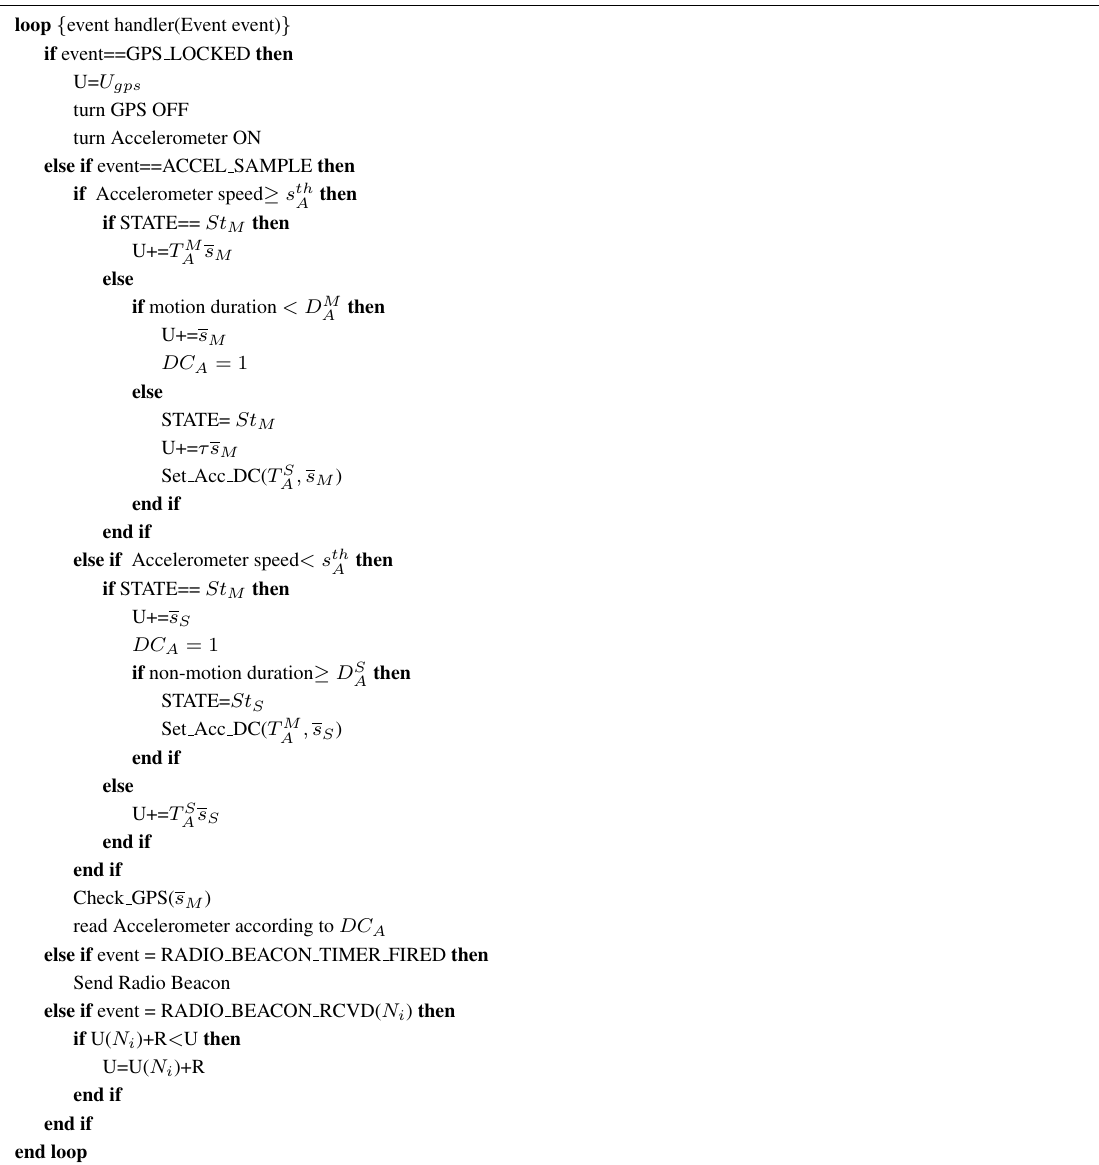
Figure 2. Accelerometer Individual Duty Cycling Strategy.